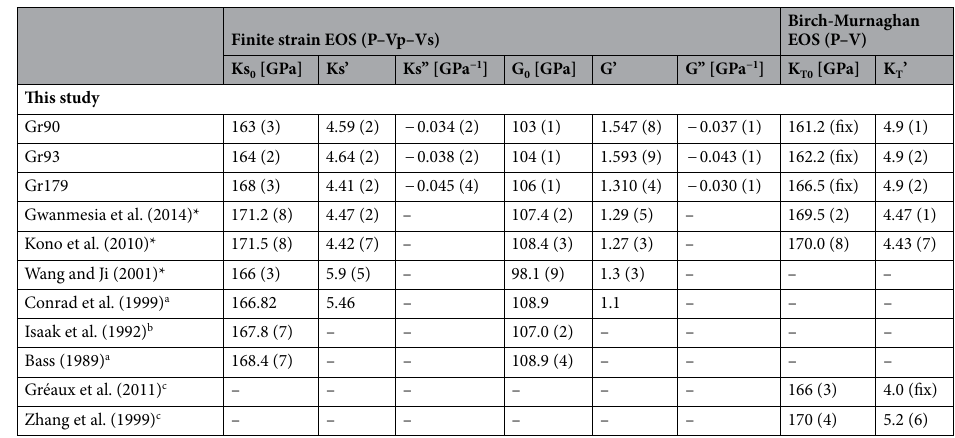
Table 1. High-pressure elastic properties of pure and near-endmember grossular samples. *Ultrasonic interferometry; a Brillouin spectroscopy; b Resonant ultrasound spectroscopy; c Static